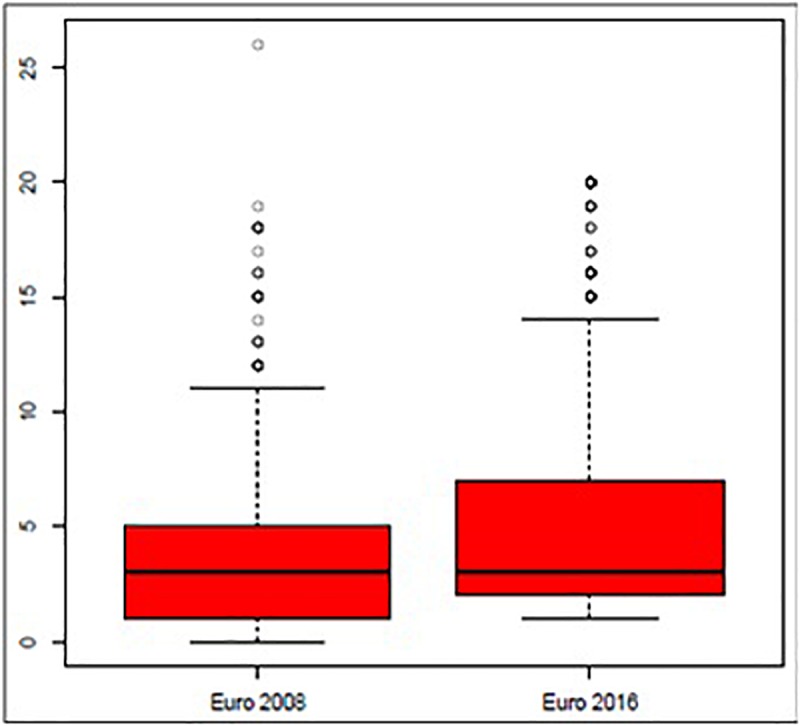
Boxplot of Number of Intervening by competition.